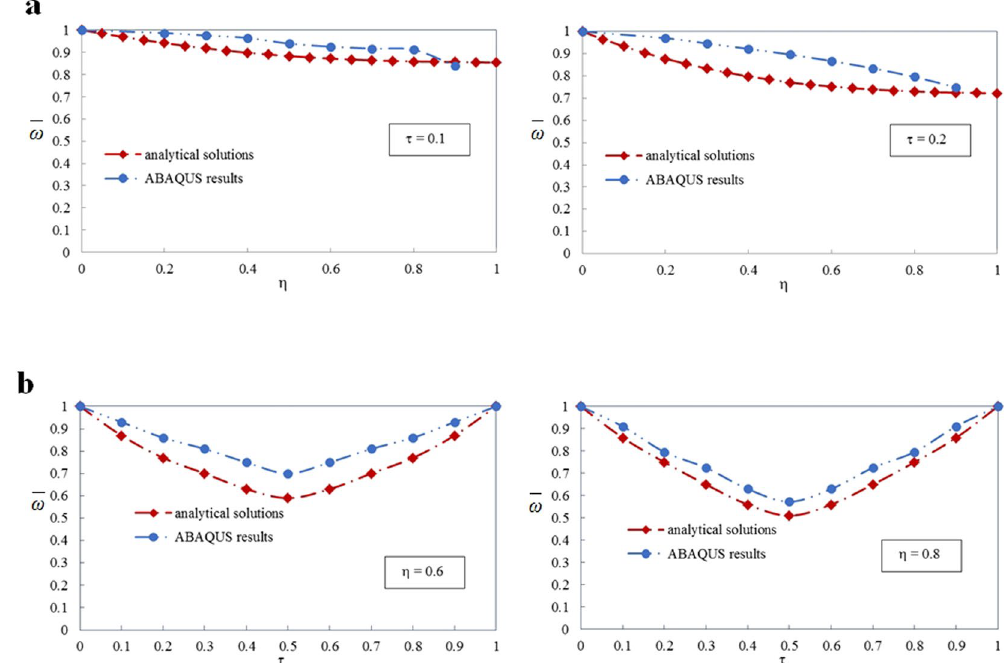
Figure 5. Influence of the geometric parameters of the delamination on the vibration frequency. ( a ) Variation of the nondimensional frequency ω with respect to the nondimensional delamination length η for the nondimensional delamination depth τ = 0.1 and τ = 0.2. ( b ) Variation of the nondimensional frequency ω with respect to the nondimensional delamination depth τ for the nondimensional delamination length η = 0.6 and η =